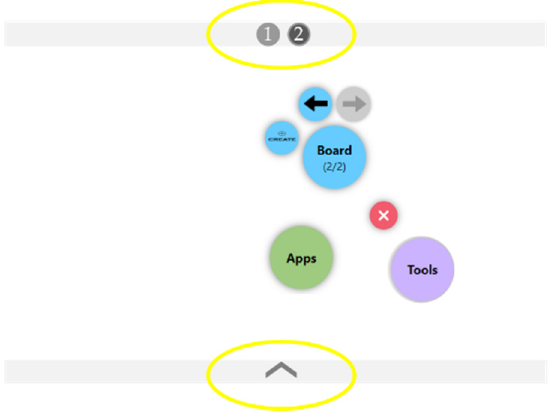
Figure 6. Navigating between boards.